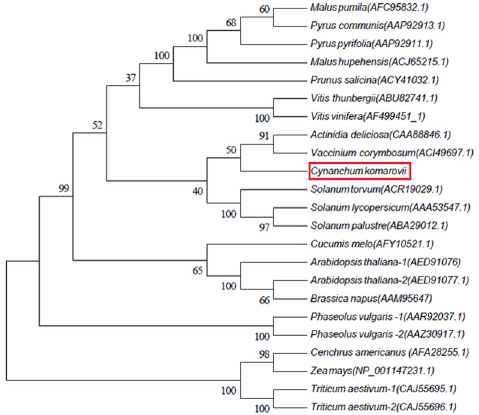
Fig 2. Phylogenetic analysis of CkPGIP1 and other known PGIPs. Amino acid sequences of CkPGIP1 (red box) and other known PGIPs were obtained from GenBank. The neighbor-joining tree was built in MEGA 5.1 based on a multiple sequence